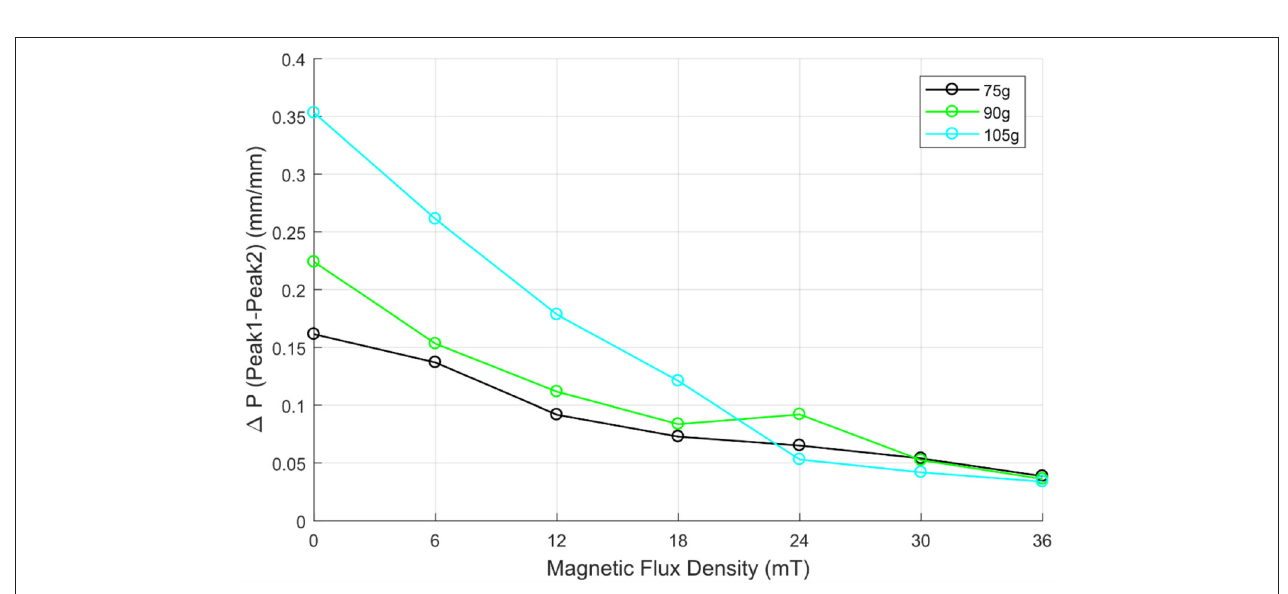
FIGURE 10 | Variation of the first two peak differences as a function of magnetic flux density for the mass of 75, 90, and